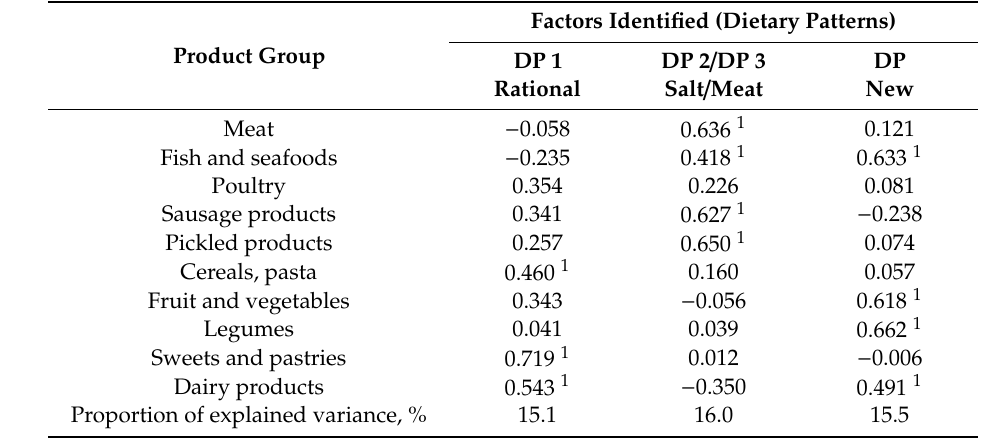
Table A17. Factor loadings of the principal dietary patterns identified (Tomsk region).